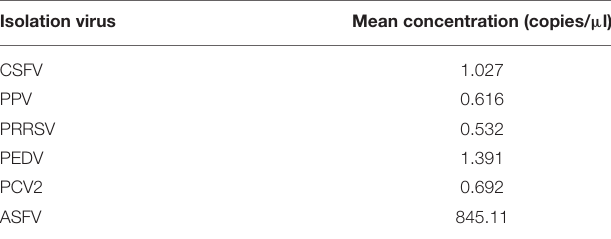
TABLE 2 | Concentration of CSFV, PPV, PCV2, PRRSV, and PEDV, and ASFV standard plasmid by cdPCR